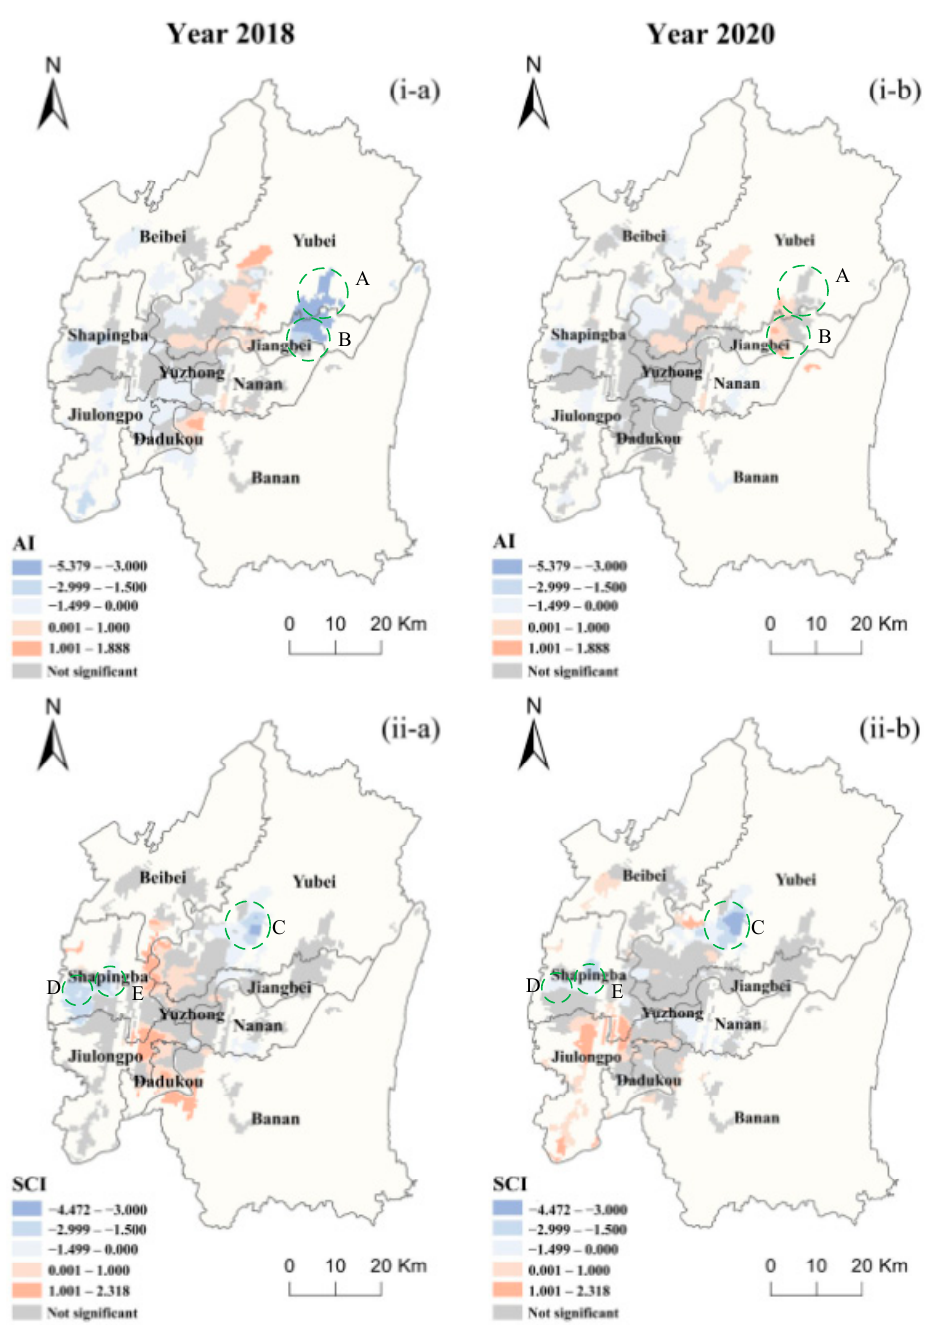
Figure 6. Spatial distributions of the coefficients of ( i ) administrative index and ( ii ) sport and cultural index in ( a ) 2018 and ( b ) 2020 (AI: administrative index; SCI: sport and cultural index. Region A is the Longxing town; Region B is the Yufu town; Region C is the Airport; Region D is the University town; Region E is the Xiyong town).